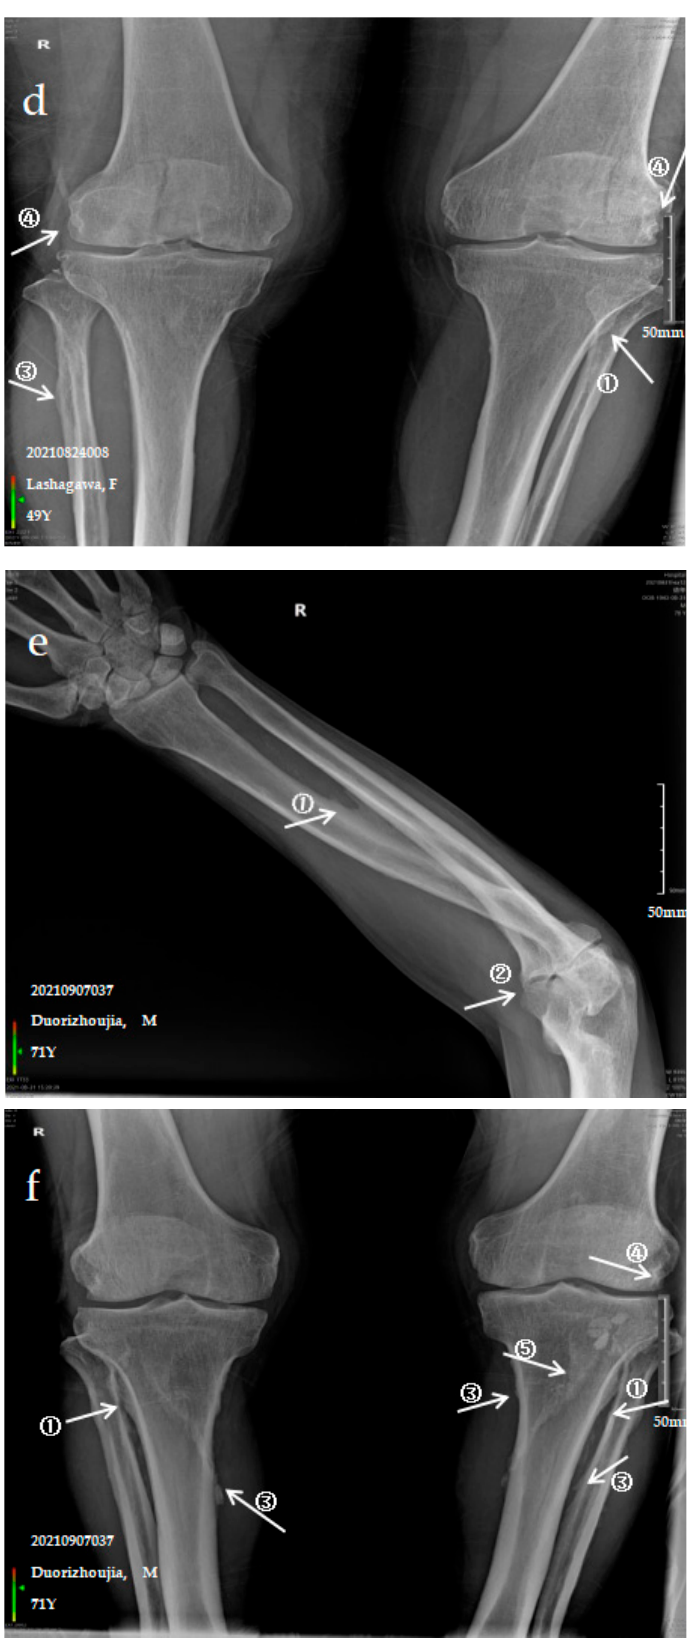
Figure 1. X-ray imaging of SF patients. The anteroposterior actinogram of the upper limb ( a ) and both lower limbs ( b ) of patient with mild SF, the anteroposterior actinogram of the upper limb ( c ) and both lower limbs ( d ) of patient with moderate SF, the anteroposterior actinogram of the upper limb ( e ) and both lower limbs ( f ) of patient with severe SF. ① : ossification of interosseous mem- brane; ② : degeneration of the elbow joint; ③ : Ossification shadow; ④ : Ossification of knee joint capsule; ⑤ : ossification of soleus tendon.